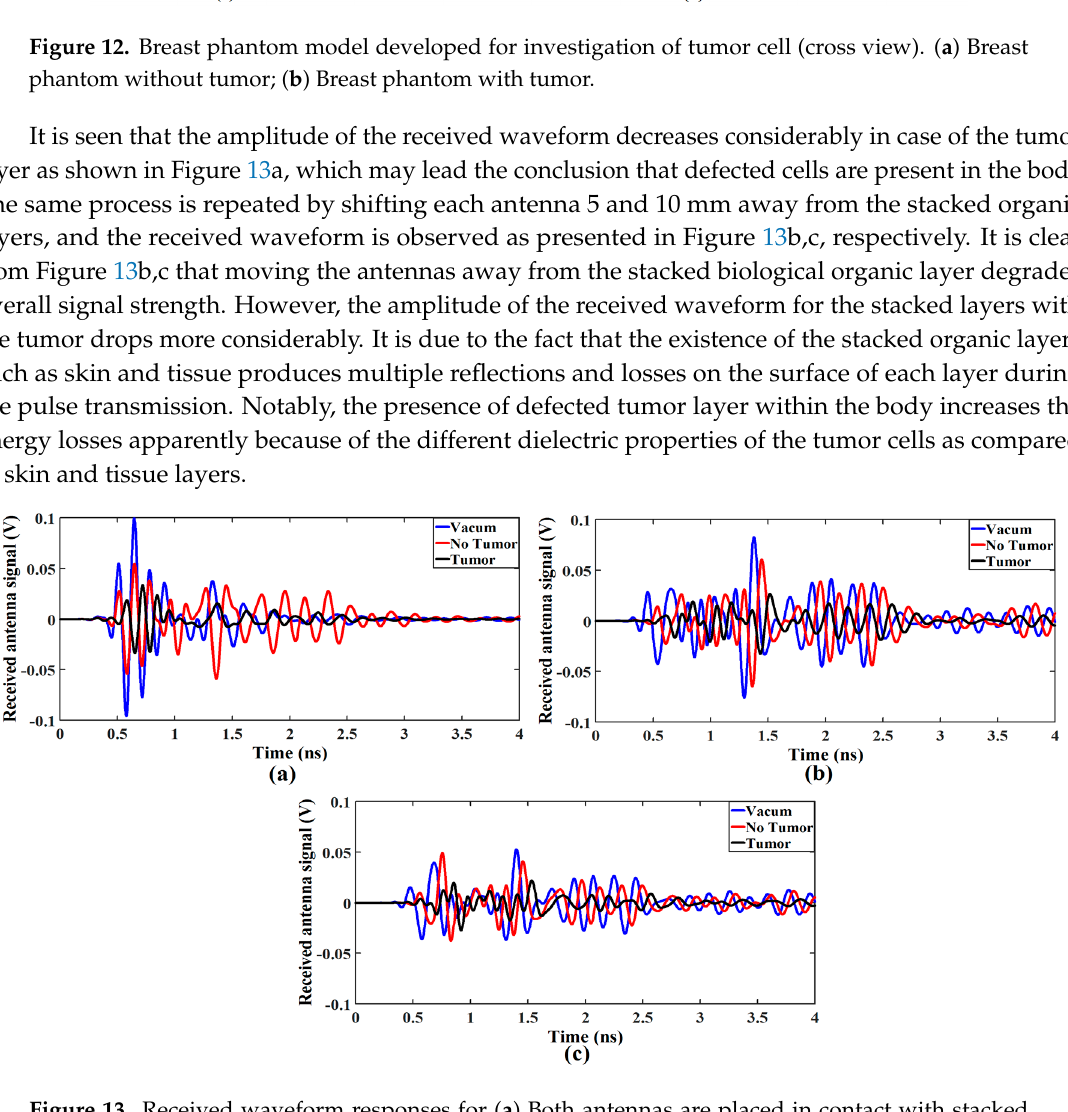
Figure 12. Breast phantom model developed for investigation of tumor cell (cross view). ( a ) Breast phantom without tumor; ( b ) Breast phantom with tumor.